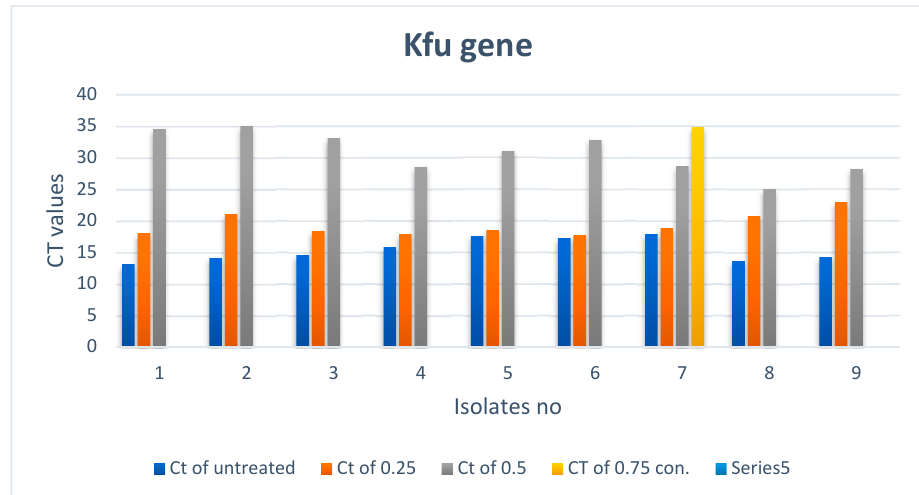
Table 4. kfu gene expression in Klebsiella pneumoniae isolates treated with different concentrations of ZnO NPs *. Treated Bacteria Isolates with Different con.